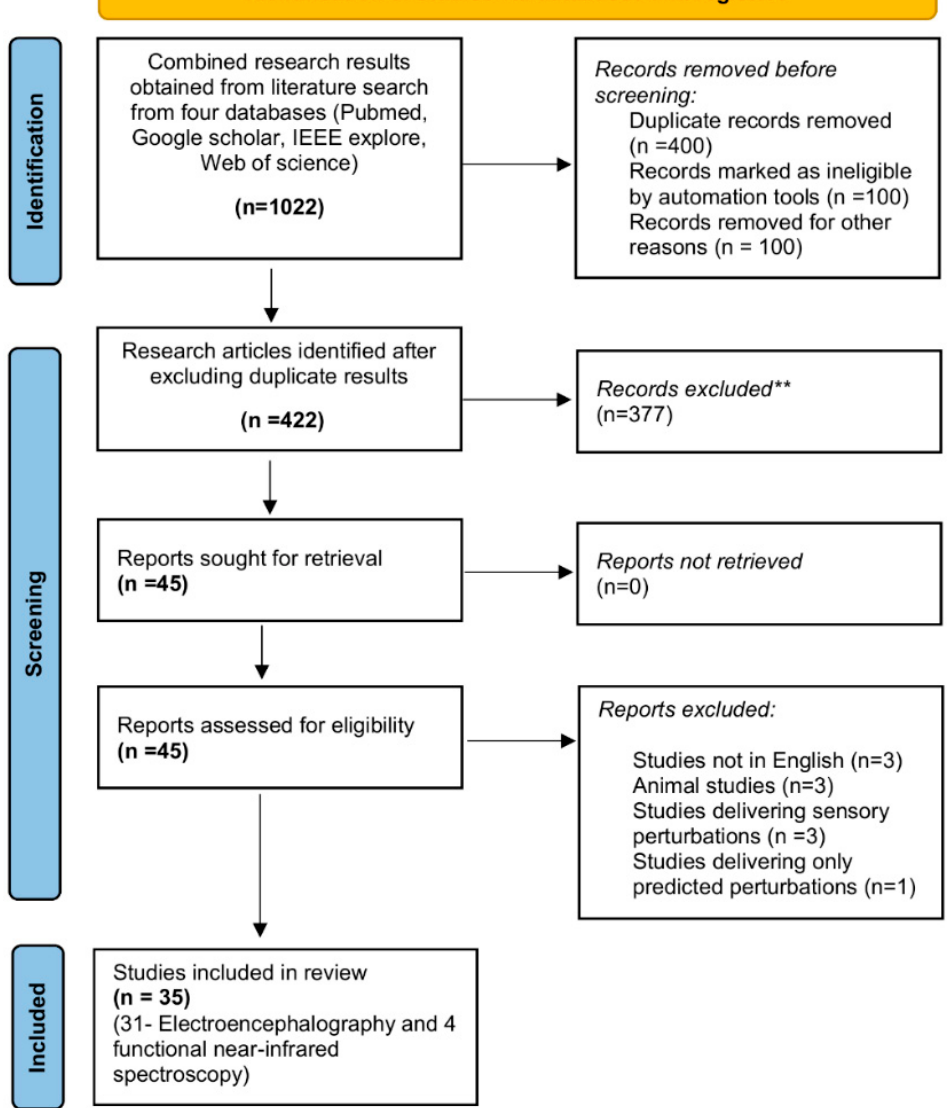
Figure 1. PRISMA 2020 flow diagram for new systematic reviews which included searches of databases: Combined search results from four databases yielded 1022 research articles out of which 600 were excluded due to duplication and ineligibility. The remaining 422 were assessed for eligibility and 377 were excluded after reviewing article abstracts. Thus, 10 articles were excluded from the remaining 45 after full-text analysis and finally 35 cross-sectional studies were included. ** Records excluded by the authors due to